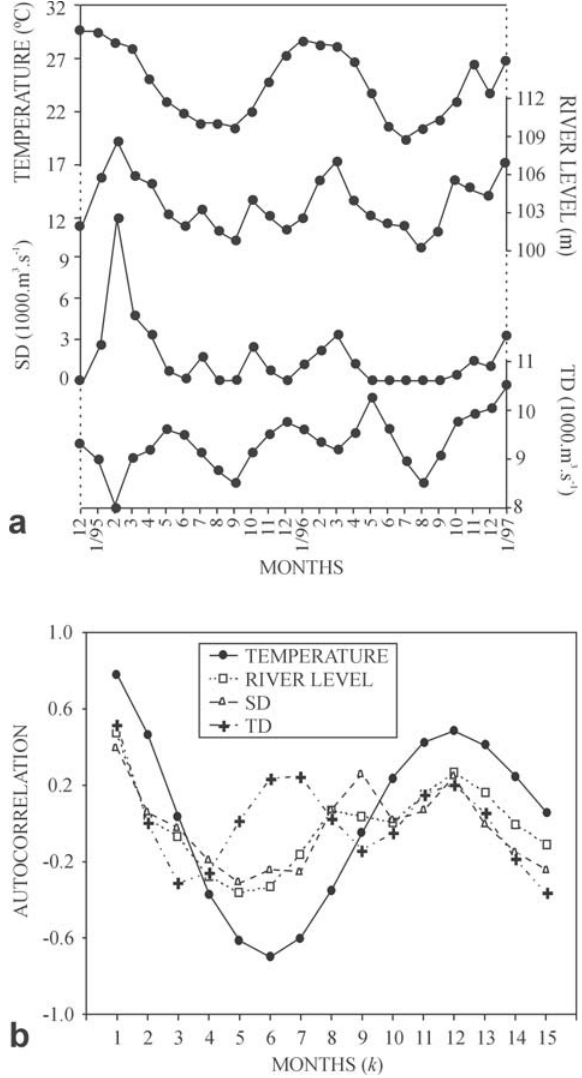
Fig. 1. Variation in temperature, river level, spillway discharge (SD) and turbine discharge (TD) at the experimental ladder located near Itaipu Dam, during the sampling period (a) and correlogram of the variables (b).